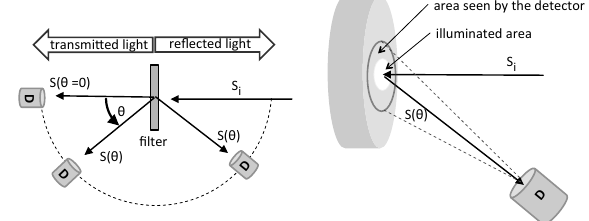
Figure 4. Polar photometer. Left: the filter is illuminated with in- tensity S i . The detector D can be turned around the center of the fil- ter and measures the intensity of the transmitted and reflected light S(θ) , respectively. Right: the field of view of the detector is suffi- ciently large that the illuminated area is within the field of view of the detector for all scattering angles θ .